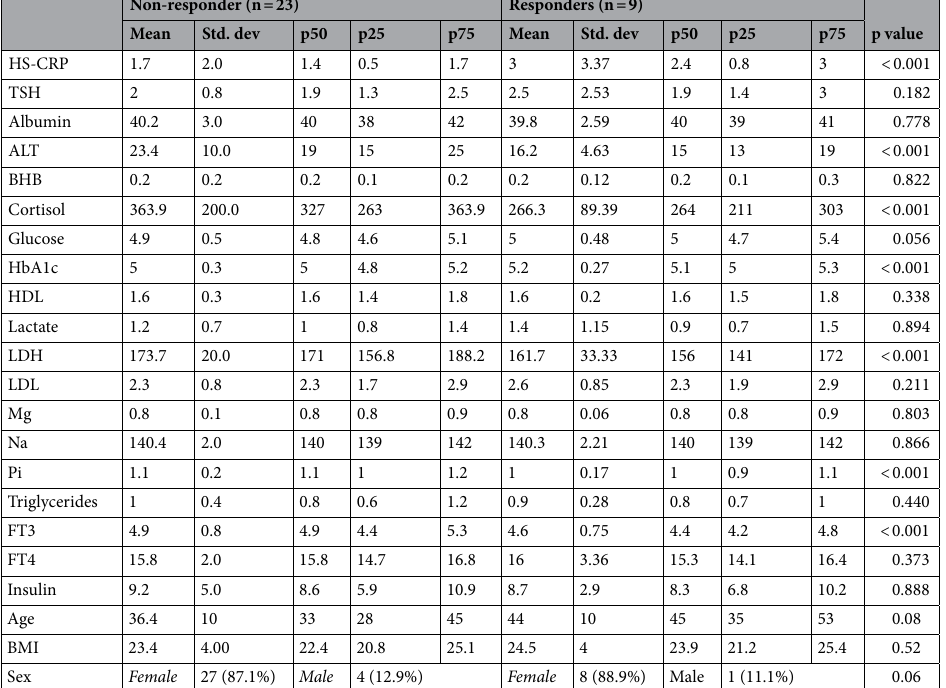
Table 1. Differences in metabolites between responders and non-responders at baseline. P-values were obtained using tableone::CreateTableOne which uses Kruskal–Wallis’s rank sum tests for non-parametric hypothesis testing.